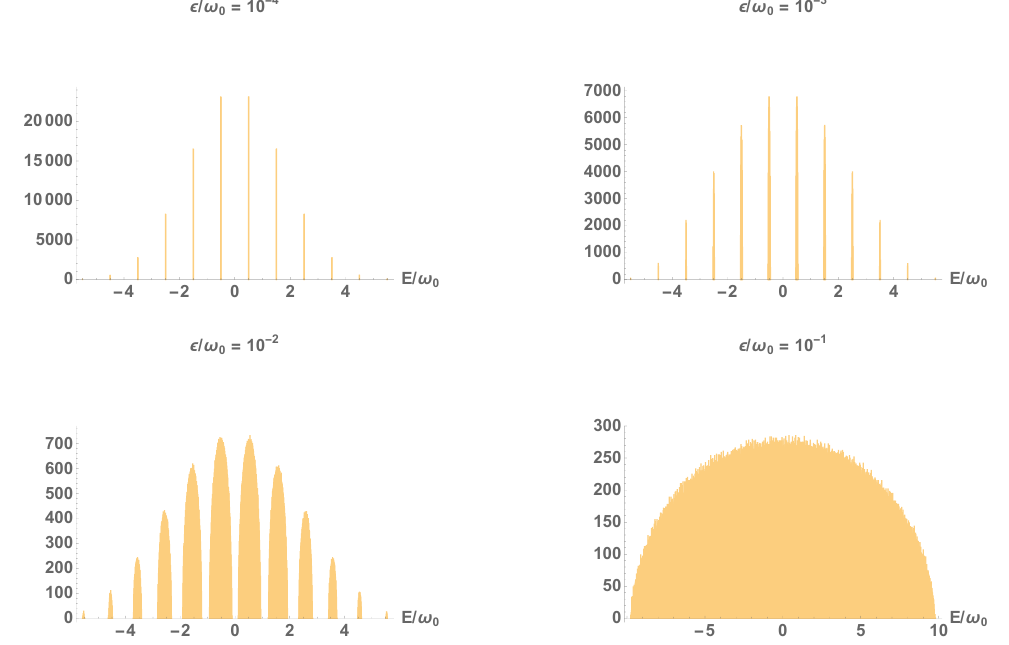
Figure 14 . Above is depiction of the averaged spectral density (histogram of eigenvalues) of a system of 11 identical fermionic oscillators coupled together with random interactions represented by a matrix pulled from a GUE for various values of (cid:15)/ω 0 . The top two plots labelled by (cid:15)/ω 0 = 10 − 4 , 10 − 3 depict the spectral density at weak coupling. The bottom two plots labelled by (cid:15)/ω 0 = 10 − 2 , 10 − 1 depict the spectral density at intermediate coupling ( (cid:15)/ω 0 = 10 − 2 ) and strong coupling ( (cid:15)/ω 0 = 10 − 1 ).